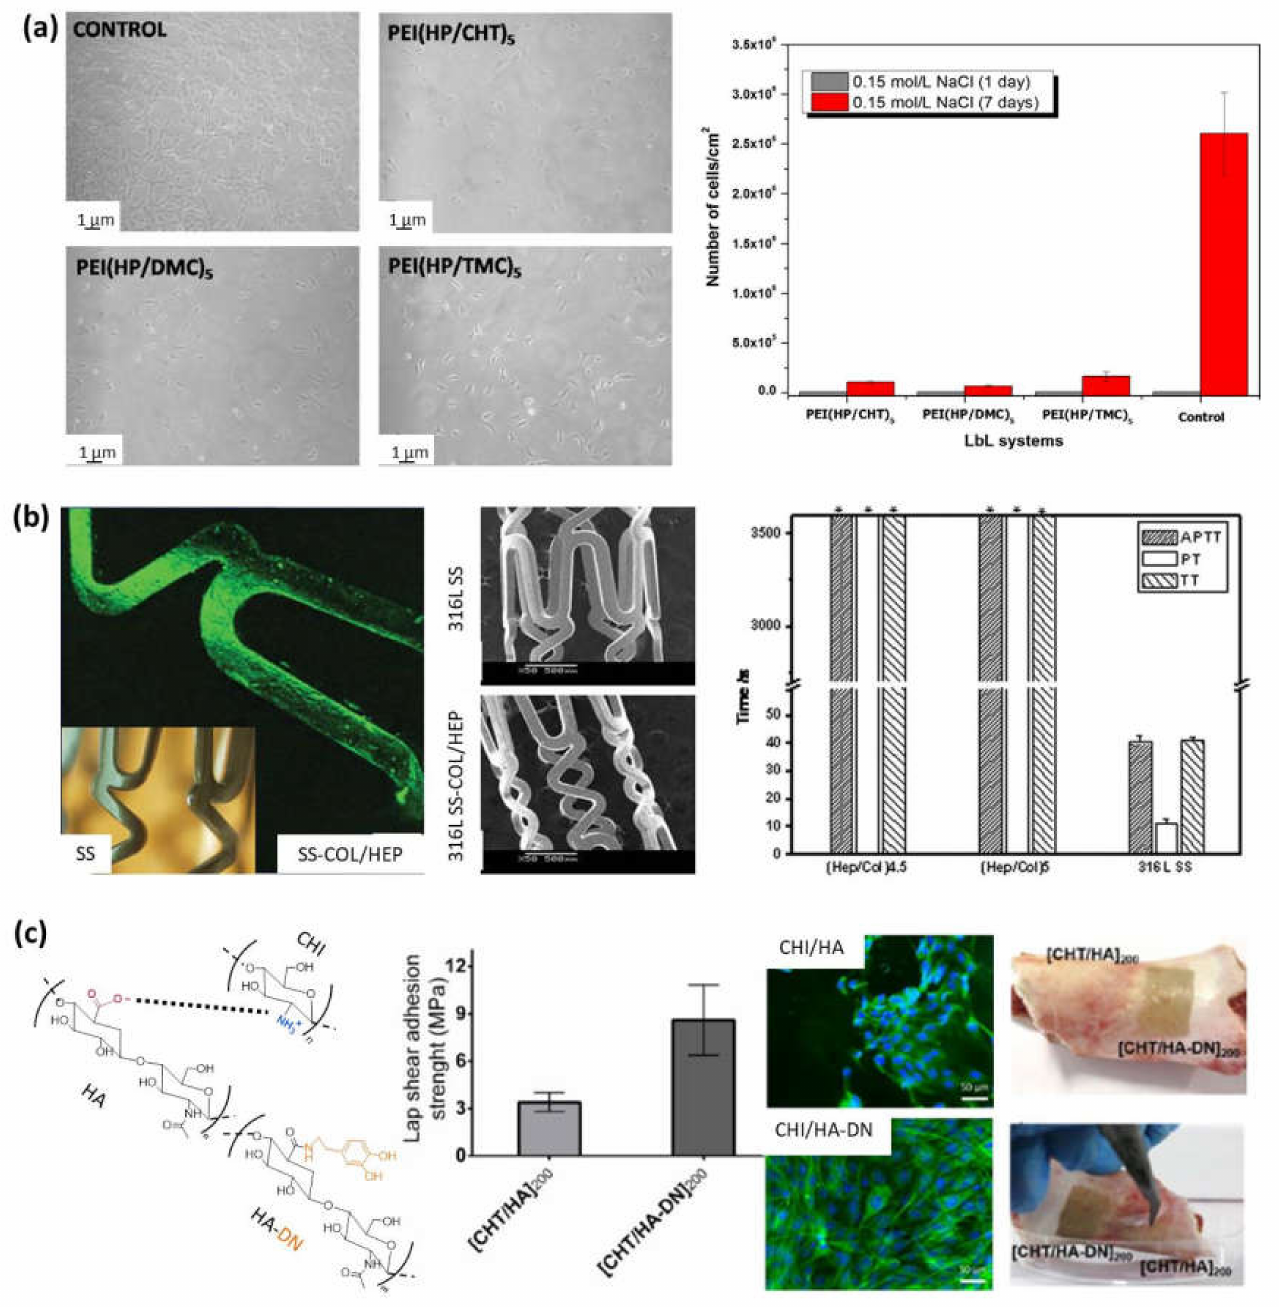
Figure 5. ( a ) NIH/3T3 fibroblasts after 1 day of contact with controls or LbL multilayer films (left), and surface cell density after 1 and 7 days (right) (Adapted and reprinted with permission from [84]; Copyright 2016 Elsevier Inc. All rights reserved); ( b ) Adapted and reprinted with permission from [90] Copyright 2010 Wiley Periodicals, Inc.; ( c ) Schematic representation of the electrostatic interaction between chitosan and hyaluronic acid (left). Adhesive properties of freestanding membranes CHI/HA and CHI/HA-DN (center). Osteopontin immunofluorescence images of MC3T3-EI cells on those membranes, and images of the adhesiveness potential of those freestanding membranes on a clean surface of porcine bone: before (right-top) and after applying a detachment force with tweezers (right) (Adapted and reprinted with permission from [91]. Copyright 2017